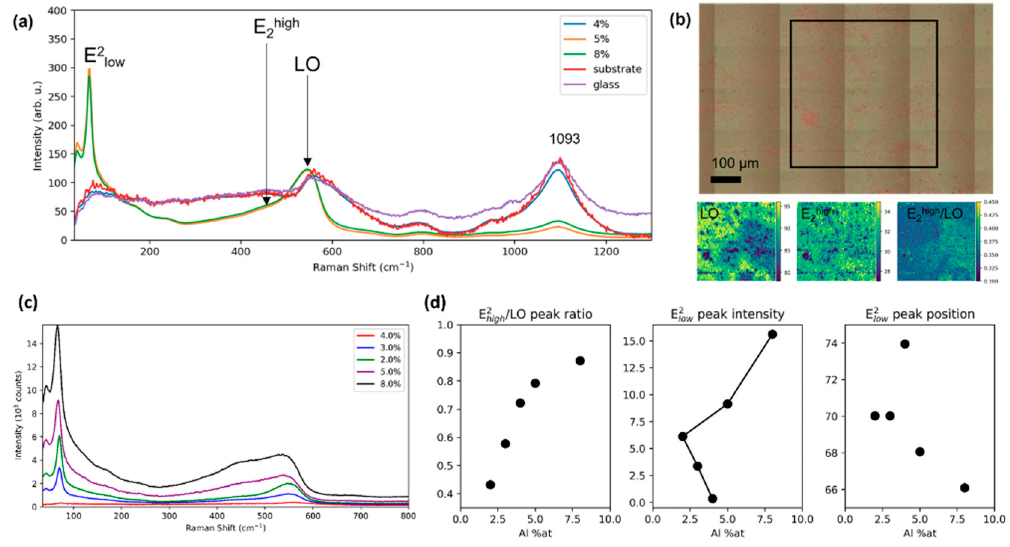
Figure 5. ( a ) Raman spectra of the AZO samples with doping concentrations of 4 at.%, 5 at.%, and 8 at.% (blue, orange, and green lines), of the substrate (red line) and of another commercial microscopy glass substrate (purple line). The spectra are extracted as the average of all the spectra collected on a spatial map, as the one reported in panel ( b ). ( c ) Raman spectra for all the samples, in the 0–800 cm − 1 range, where the ZnO vibrational features (E 2low peak, E 2high , and the LO band) are localized. ( d ) E 2high /LO intensity ratio, E 2low peak intensity, and E 2low peak spectral position as a function of